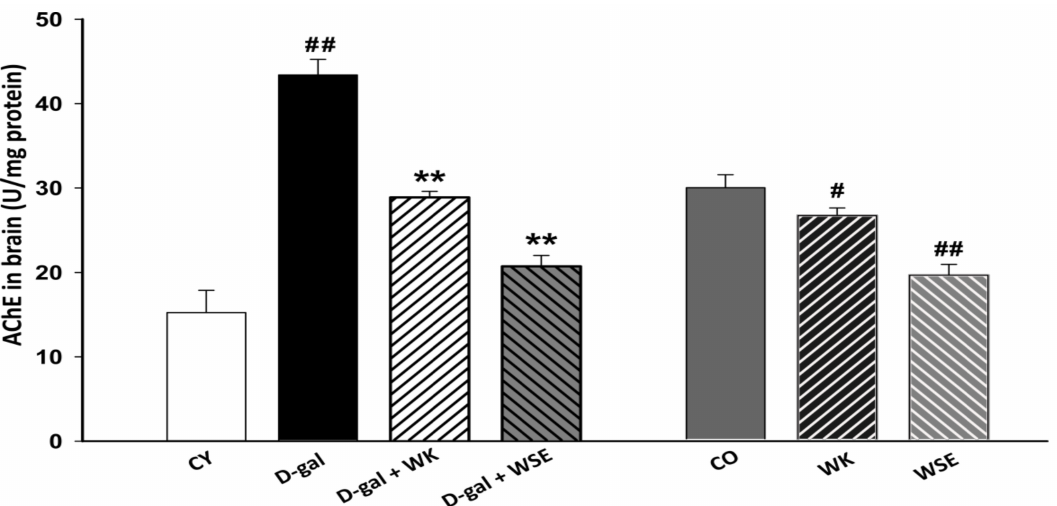
Figure 8. AChE level in the brain of D-gal-induced aging and naturally aged rats (values expressed as mean ± SD; n = 5); # p < 0.05 and ## p < 0.01 compared to CO or CY; ** p < 0.01 in D-gal + WK and D-gal + WSE compared to D-gal group (CO—control old; CY—control young; D-gal—D-galactose; WK—walnut kernel; WSE—walnut septum